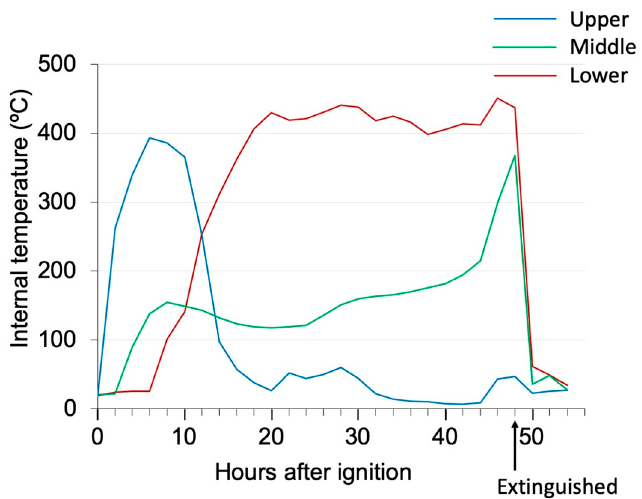
Figure 2. Temporal changes in the internal temperature of the oil-drum carbonizer at three different heights of 15 cm (lower), 45 cm (middle), and 75 cm (upper) from the bottom of the drum. The pyrolysis was terminated at 48 h after ignition (vertical arrow).